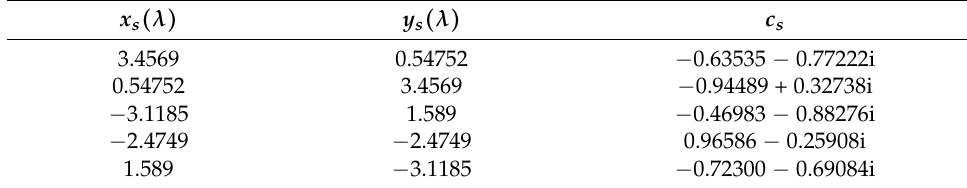
Table 2. Position of the measurement points. The third coordinate is: z m = x m